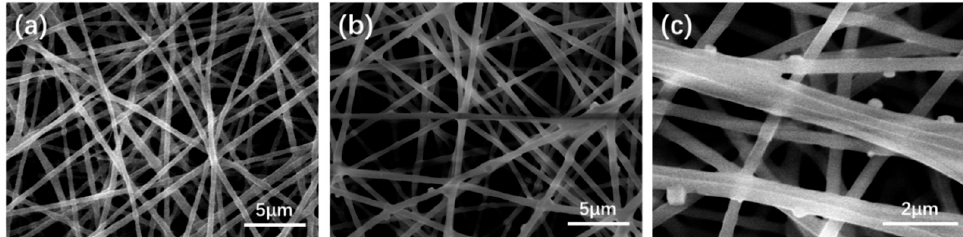
Figure 2. SEM images of ( a ) PLA-NF and ( b ) PS2-NF after mineralization for 3 days, ( c ) is high magnification of ( b ).